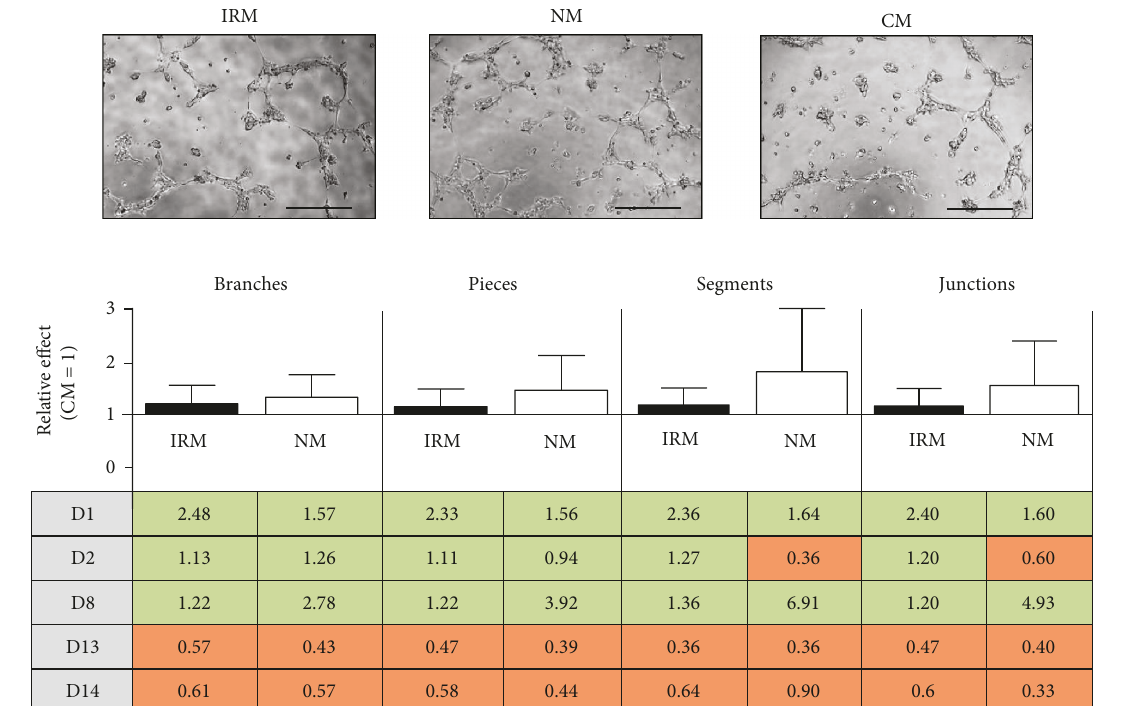
Figure 5: E ff ects of cell culture media derived from Mreg cultures subjected to I/R on endothelial tube formation. Scale bars in the photomicrographs denote 100 μ m. IRM: ischemia/reperfusion-conditioned media; NM: normoxia-conditioned media; CM: control media. Green color denotes an increase; orange color denotes a decrease of the respective tube formation parameter. D1, D2, D8, D13, and D14 classify the donors from which the respective Mreg were derived; N = 5